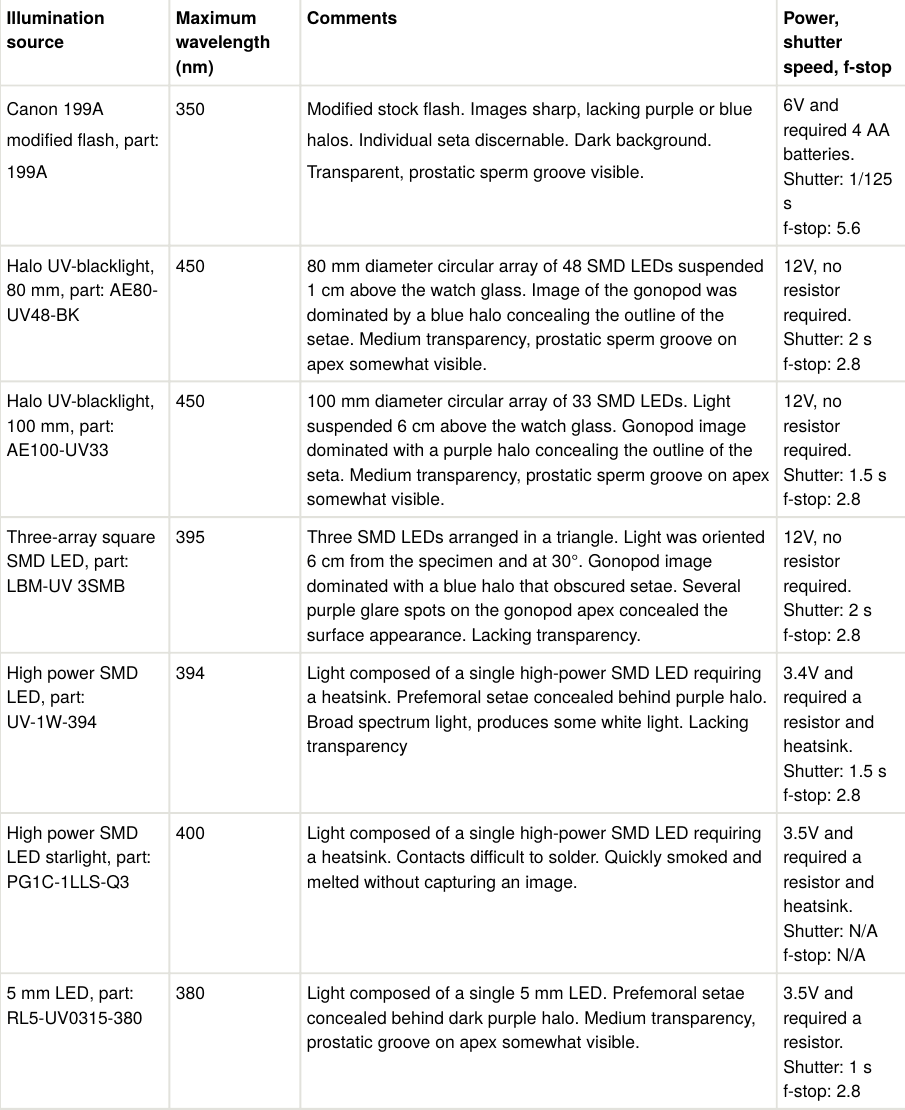
Illumination sources assessed in the study. Images of light sources shown in Suppl.